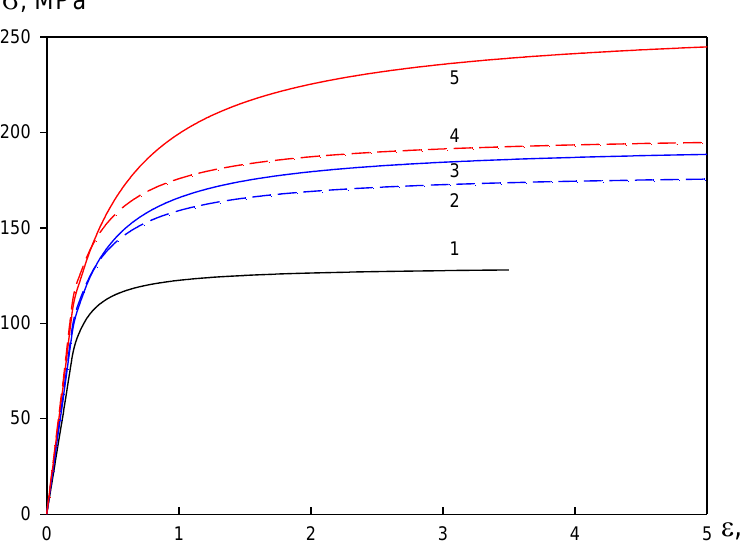
Figure 4. Loading diagrams of aluminum alloys: 1 — A356; 2 — A356 – 0.2% Al 2 O 3 ; 3 — A356 – 0.2% ScF 3 ; 4 — A356 – 1% Al 2 O 3 ; 5 — A356 – 1% ScF 3 . Table 1. Mechanical properties of aluminum alloys.